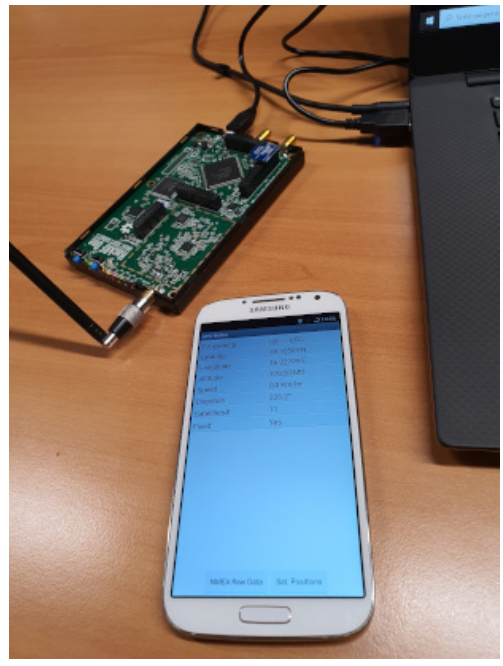
Figure 4. HackRF One with its ANT500 antenna and Tiny TCXO 10 Mhz oscillator and smartphone used as GPS